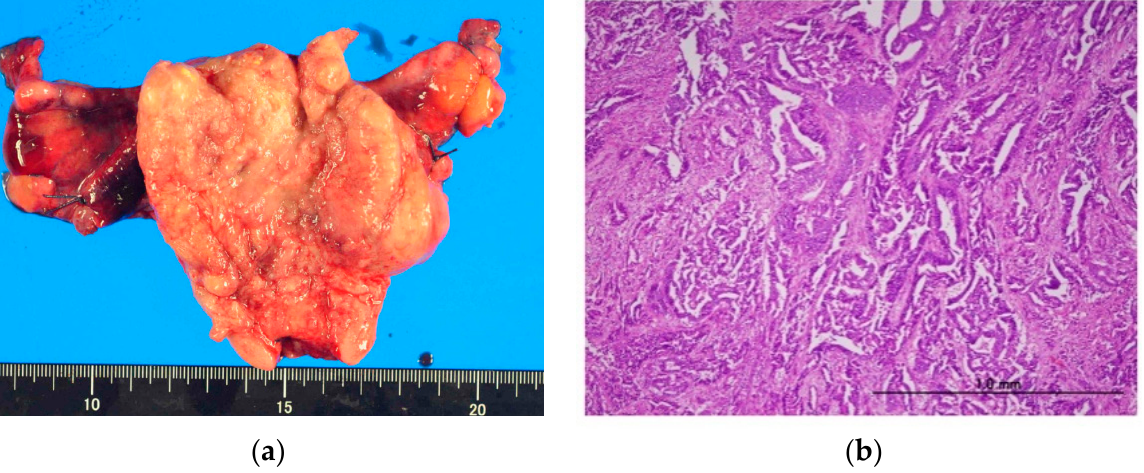
Figure 2. ( a ) Surgical fi ndings showing a high volume tumor in the uterine corpus; ( b ) pathological diagnosis: endometrioid carcinoma G3.